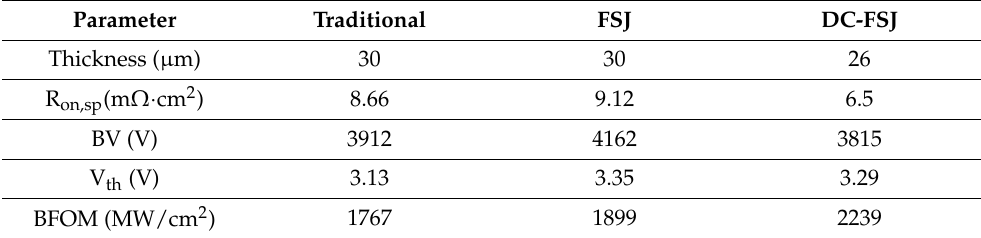
Table 1. Comparison of the characteristics of the three MOSFET structures.